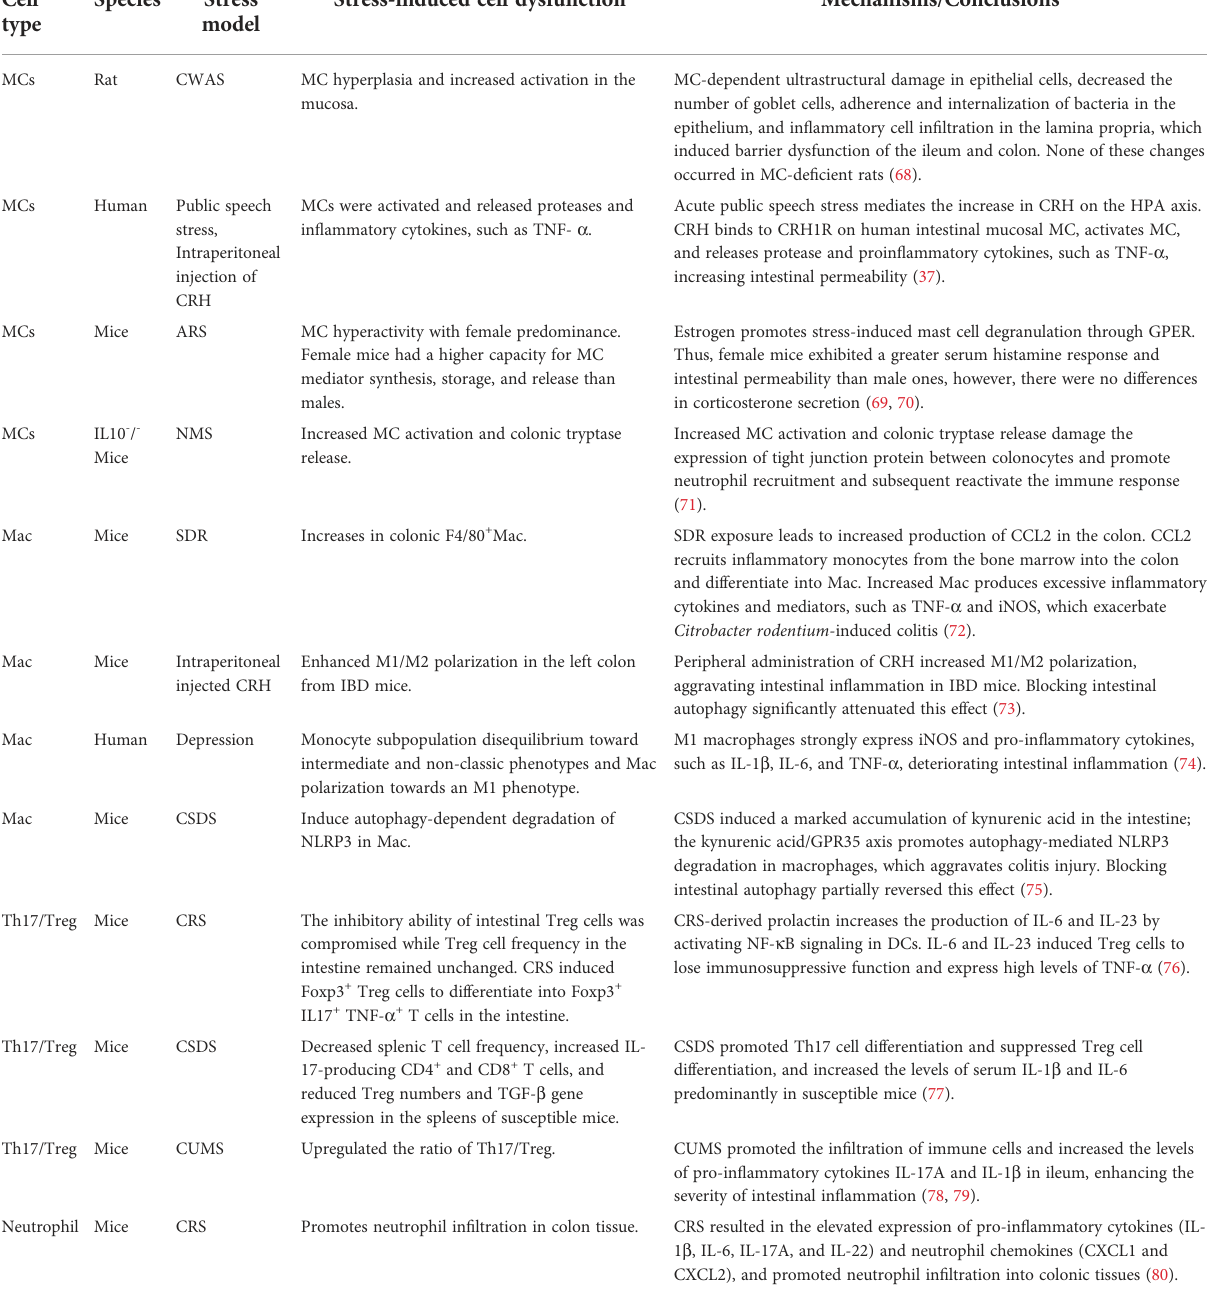
TABLE 1 Stress-induced dysfunction of speci fi c immune cells and mechanisms promoting IBD development/in fl ammatory aggravation. Cell